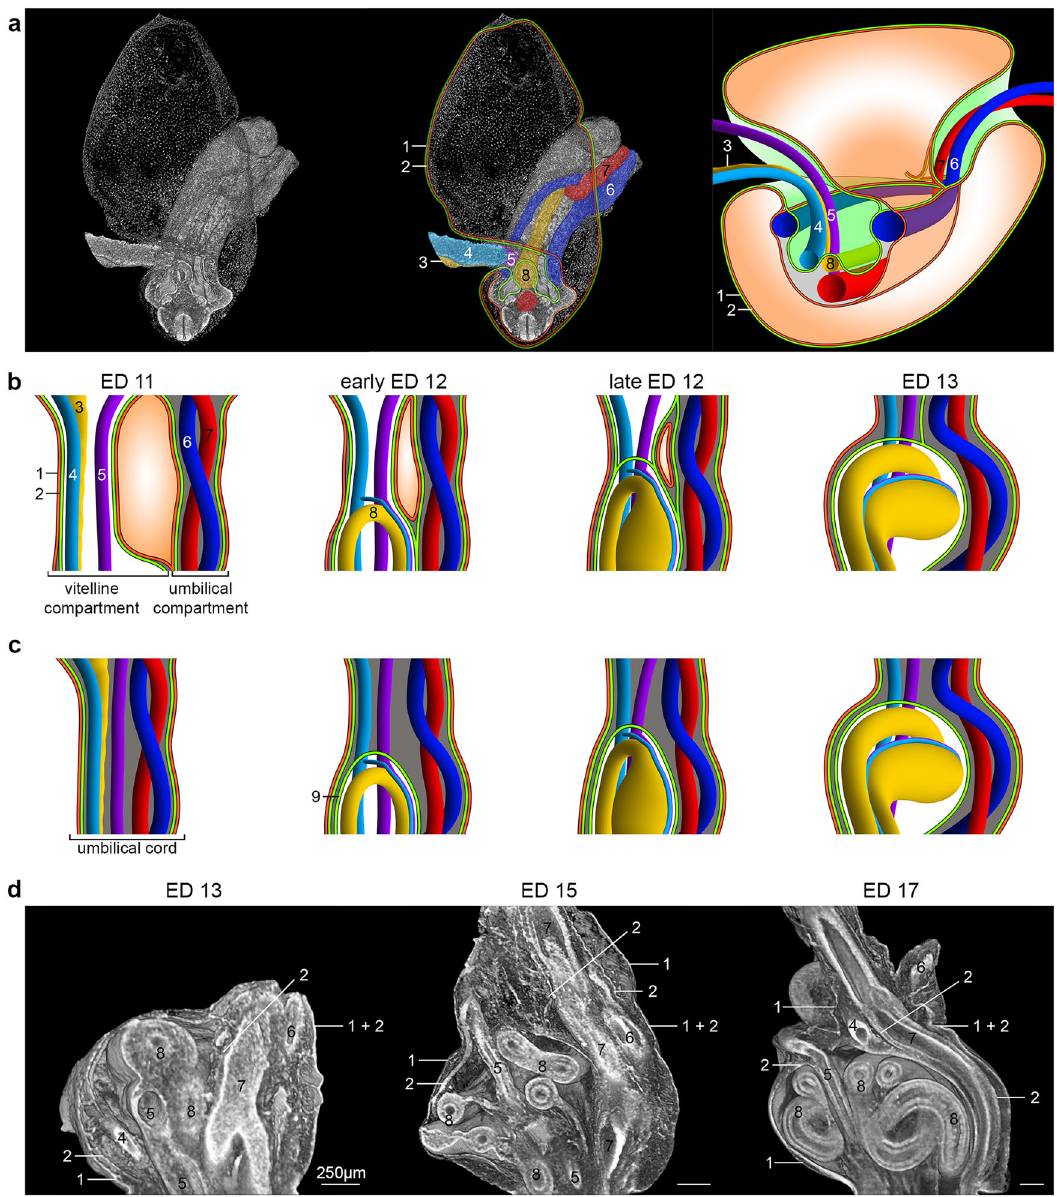
Fig. 3 Comparison of extraembryonic coelom development during umbilicus formation. a Steps from a reconstructed ED 11 embryo with a view of the abdominal area (the head was virtually removed) to a schematic illustration. b Our concept of extraembryonic coelom development. Here, the umbilicus is not represented by the umbilical cord only but by two compartments formed by the amnion. Initially, these are clearly separated at ED 11 but then aggregate to form the de fi nitive umbilicus until ED 13. In this process, the vitelline compartment, which is continuous between the intra- and extraembryonic coelom of the embryo until late ED 12, is sealed ventrally to form the coelomic sac, covering the extraembryonic midgut loops. c Common schematic illustration of extraembryonic coelom development 4,16 . According to these drawings, the extraembryonic coelom appears in the context of the “ herniation of the midgut ” , which occurs inside the umbilical cord. d Representative reconstructions of embryos from ED 13 to ED 17 showing the structures of the de fi nitive umbilicus. 1: Ectodermal component of the amnion, 2: Mesodermal component of the amnion, 3: Ductus omphaloentericus, 4: Vitelline vein, 5: Vitelline artery, 6: Umbilical vein, 7: Umbilical artery, 8: Midgut, and 9: Mesoderm surrounding the gut, forming the extraembryonic